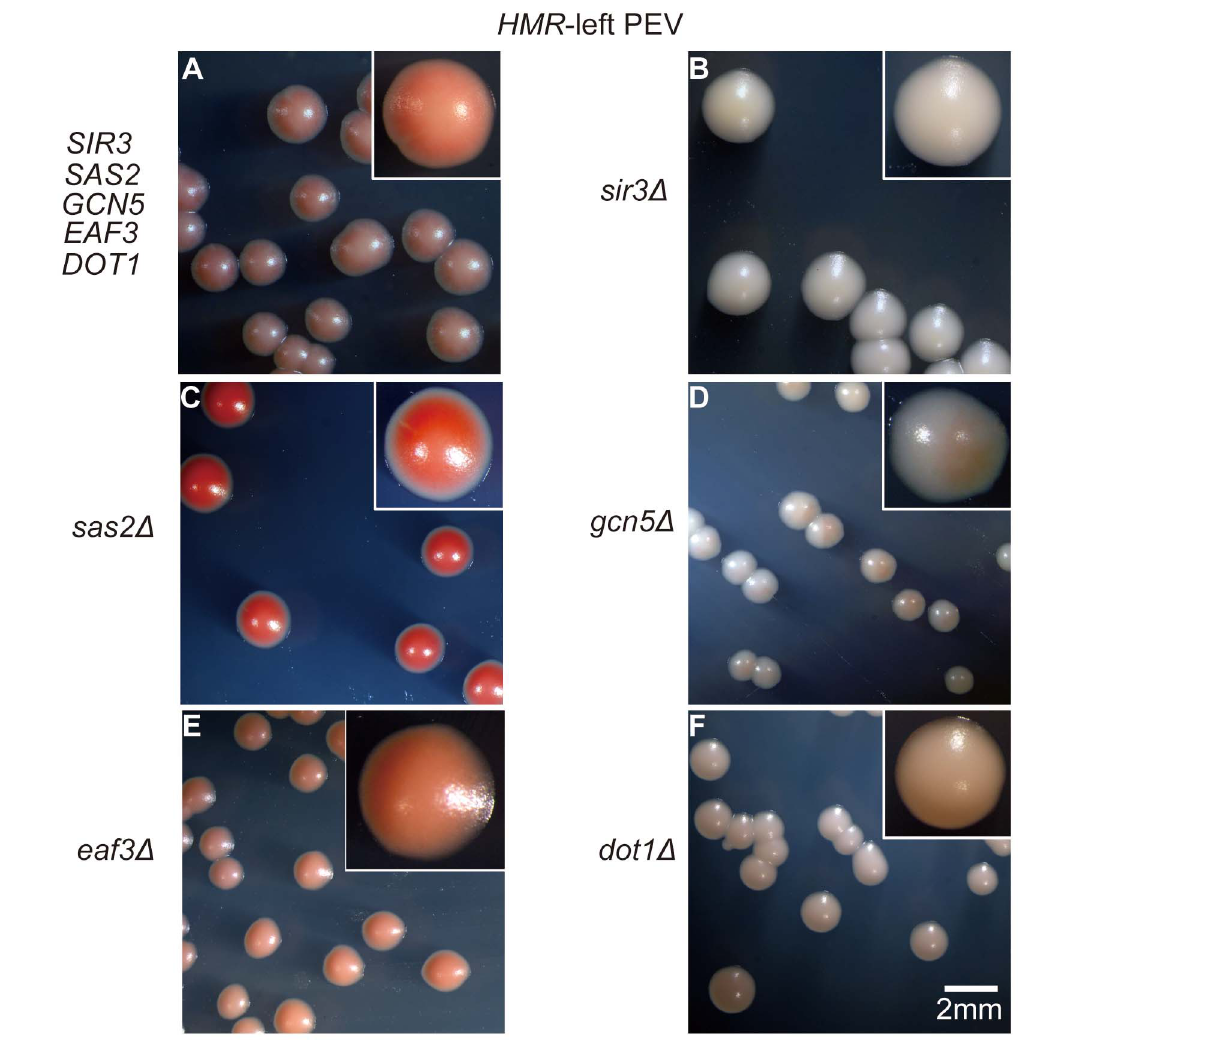
Figure 6. Position effects at the HMR -left region assessed using strains containing disrupted histone modification enzyme genes. The ADE2 gene was inserted into the HMR -left region of various deletion strains and a colony color assay was performed. The control strain was HMR - left PEV (FUY329) (A) and the deletion strains were HMR -left PEV + sir3 D (FUY341) (B), HMR -left PEV + sas2 D (FUY346) (C), HMR -left PEV + gcn5 D (FUY791) (D), HMR -left PEV + eaf3 D (FUY814) (E), and HMR -left PEV + dot1 D (FUY820) (F). Freshly grown yeast cells were spread onto SC plates (containing 10 m g/ ml adenine) and were incubated at 30 u C for 2–3 d. Scale bar, 2 mm. the gene expression states of the HMR -left and HMR -right regions, as well as between the HMR and HML regions.